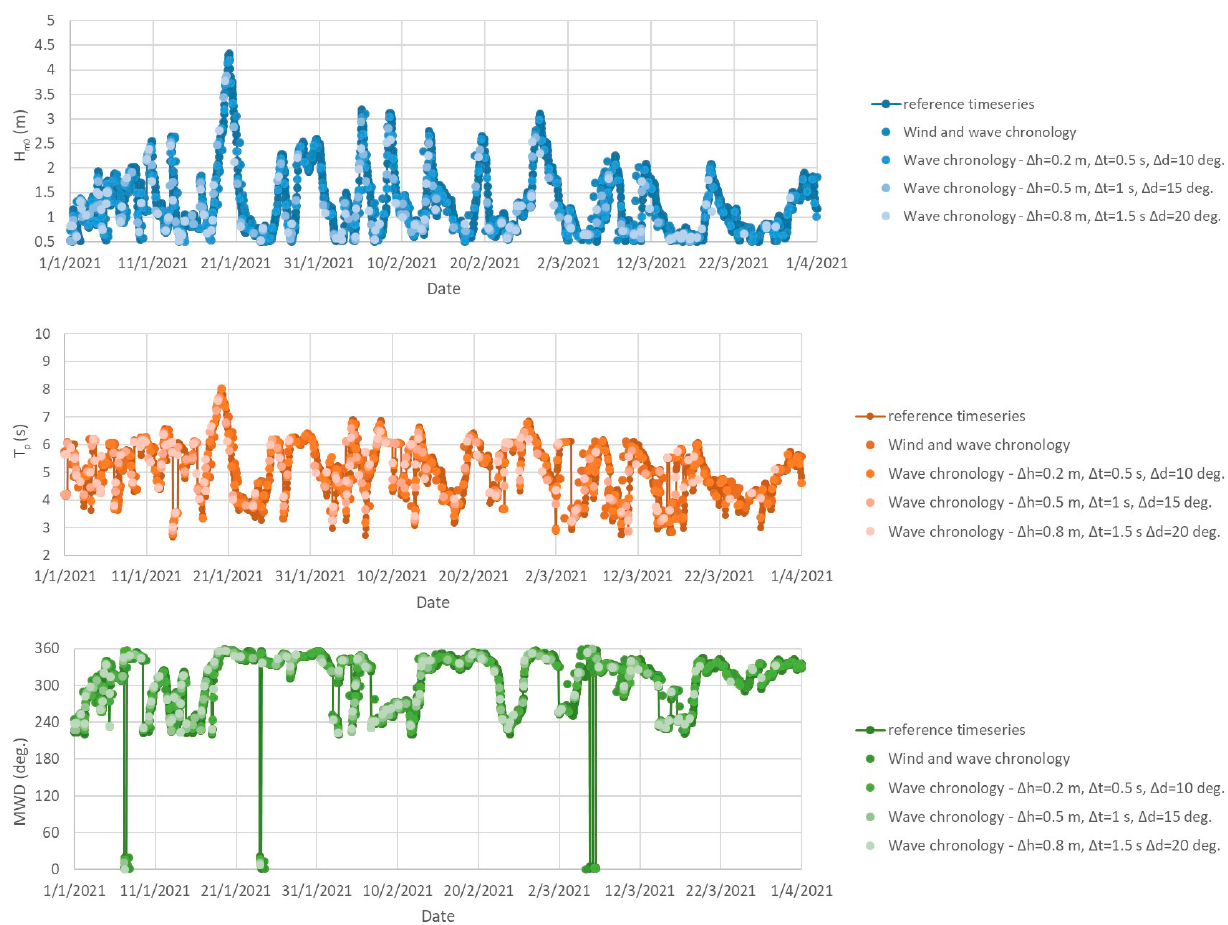
Figure 7. Diagrams of the reference time series and the four chronology-based reduction techniques’ time series for H m 0 ( up ), T p ( middle ), and MWD ( below ).